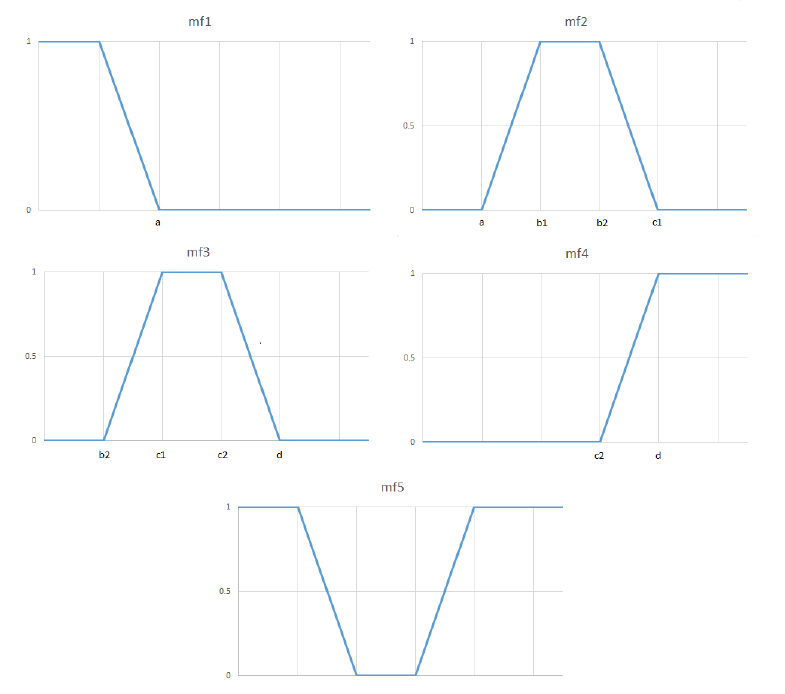
Figure 2. Membership functions in the fuzzy